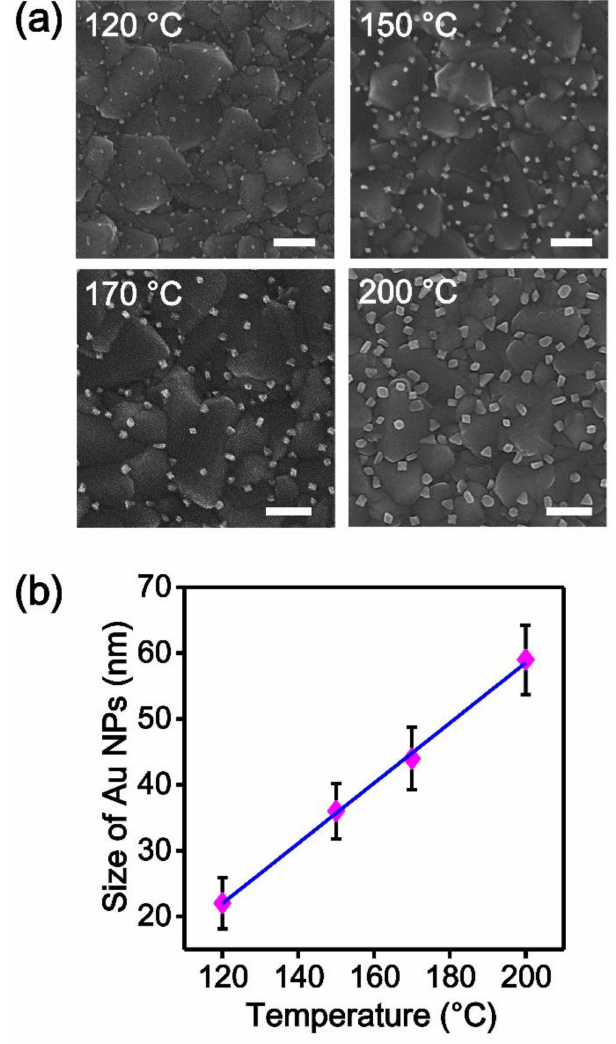
Figure 3. ( a ) Scanning electron microscopy (SEM) images of the Au nanoparticles (NPs) grown on fluorine-doped tin oxide (FTO) substrates. The size of the Au NPs increased as the reaction temperature increased from 120 to 200 ◦ C. Scale bar is 200 nm. ( b ) Plot of the average size of the Au NPs versus the reaction temperature. The average size of the Au NPs increased from 23 ± 3.9 nm to 36 ± 4.2 nm, 44 ± 4.7 nm, and 59 ± 5.3 nm with the increase in the reaction temperature. The linear fit line is also shown (blue). Data represent the mean plus standard deviation from twenty